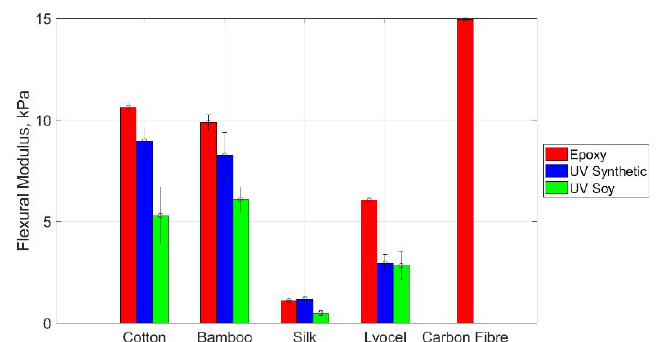
Figure 3. Comparison of the flexural modulus of samples produced using different resin and matrix types. Range bars are presented based on measurements from all samples in that class, e.g., the average and range bars on the epoxy cotton data are based on measurements of both repeats of both weave directions with and without sodium hydroxide treatment, representing eight samples.